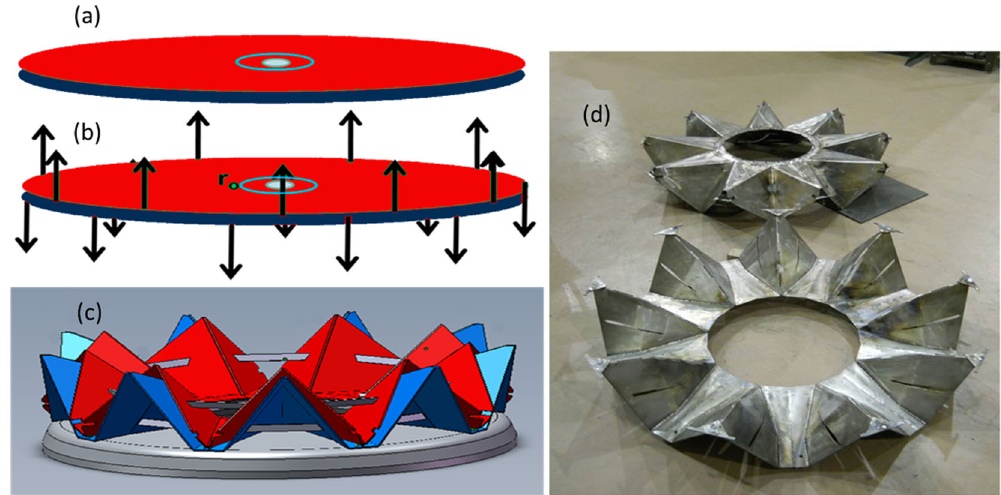
FIG. 1. The progression from a single disk feed (a) by alternating up-down vertical displacements (b) to form the CSMITL (c) does not introduce any magnetic nulls. The gray and black braces connecting the outside of adjacent vanes in (c) increase the mechanical rigidity. The Saturn CSMITL hardware is shown (d). The anode is in the foreground. The cathode, in the background, has been flipped 180° onto its top; the concave cathode vane closest to the anode fits on top of the convex anode vane adjacent to it. The slots in the cathode were cut to see if they channeled the current to enhance the magnetic field at the top of each vane to reduce the residual losses. As explained in Sec. V D, these losses are caused by gradB drifts, so the vanes had little